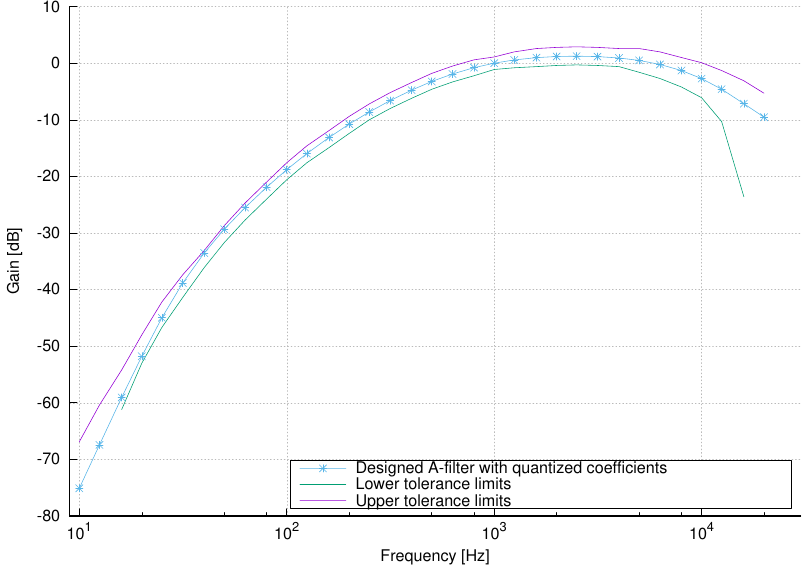
Figure 9. Magnitude response of the A-weighting filter with quantized